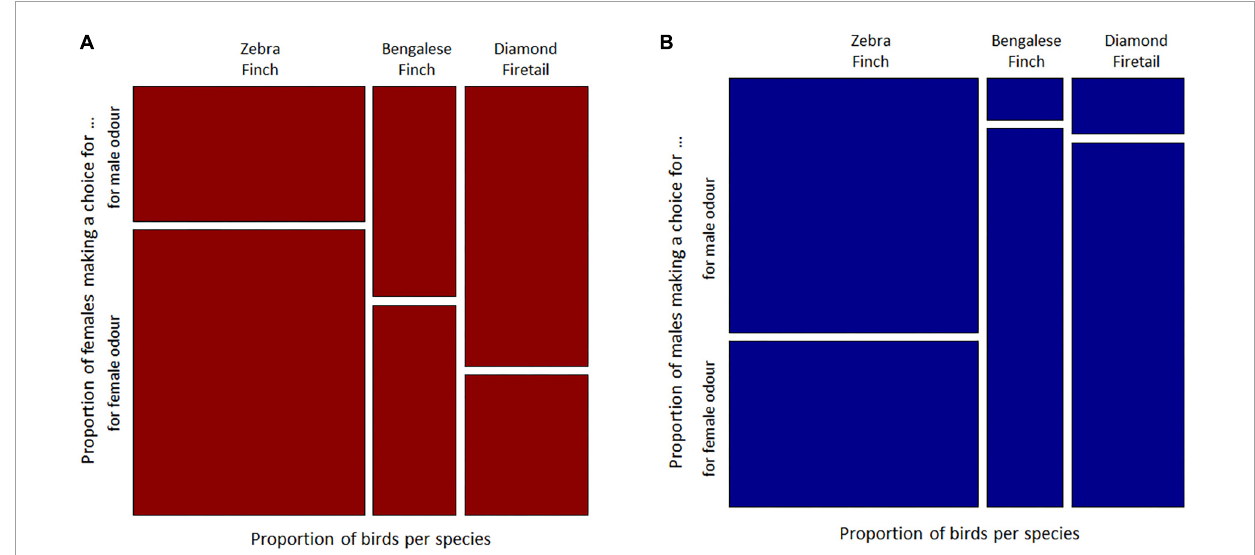
FIGURE2 Visualisation of the olfactory preference behaviour of three species of Estrildid Finches Zebra Finches, Bengalese Finches and Diamond Firetail, scale to proportions of choices made for conspecifics male or conspecifics female odour in the Y-maze respectively for (A) focal female and (B) focal males of each respective species.